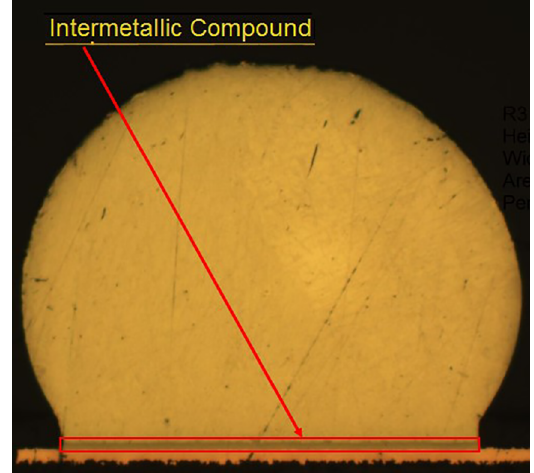
Figure 5. Intermetallic compound formed between the solder boll and the substrate (00x).